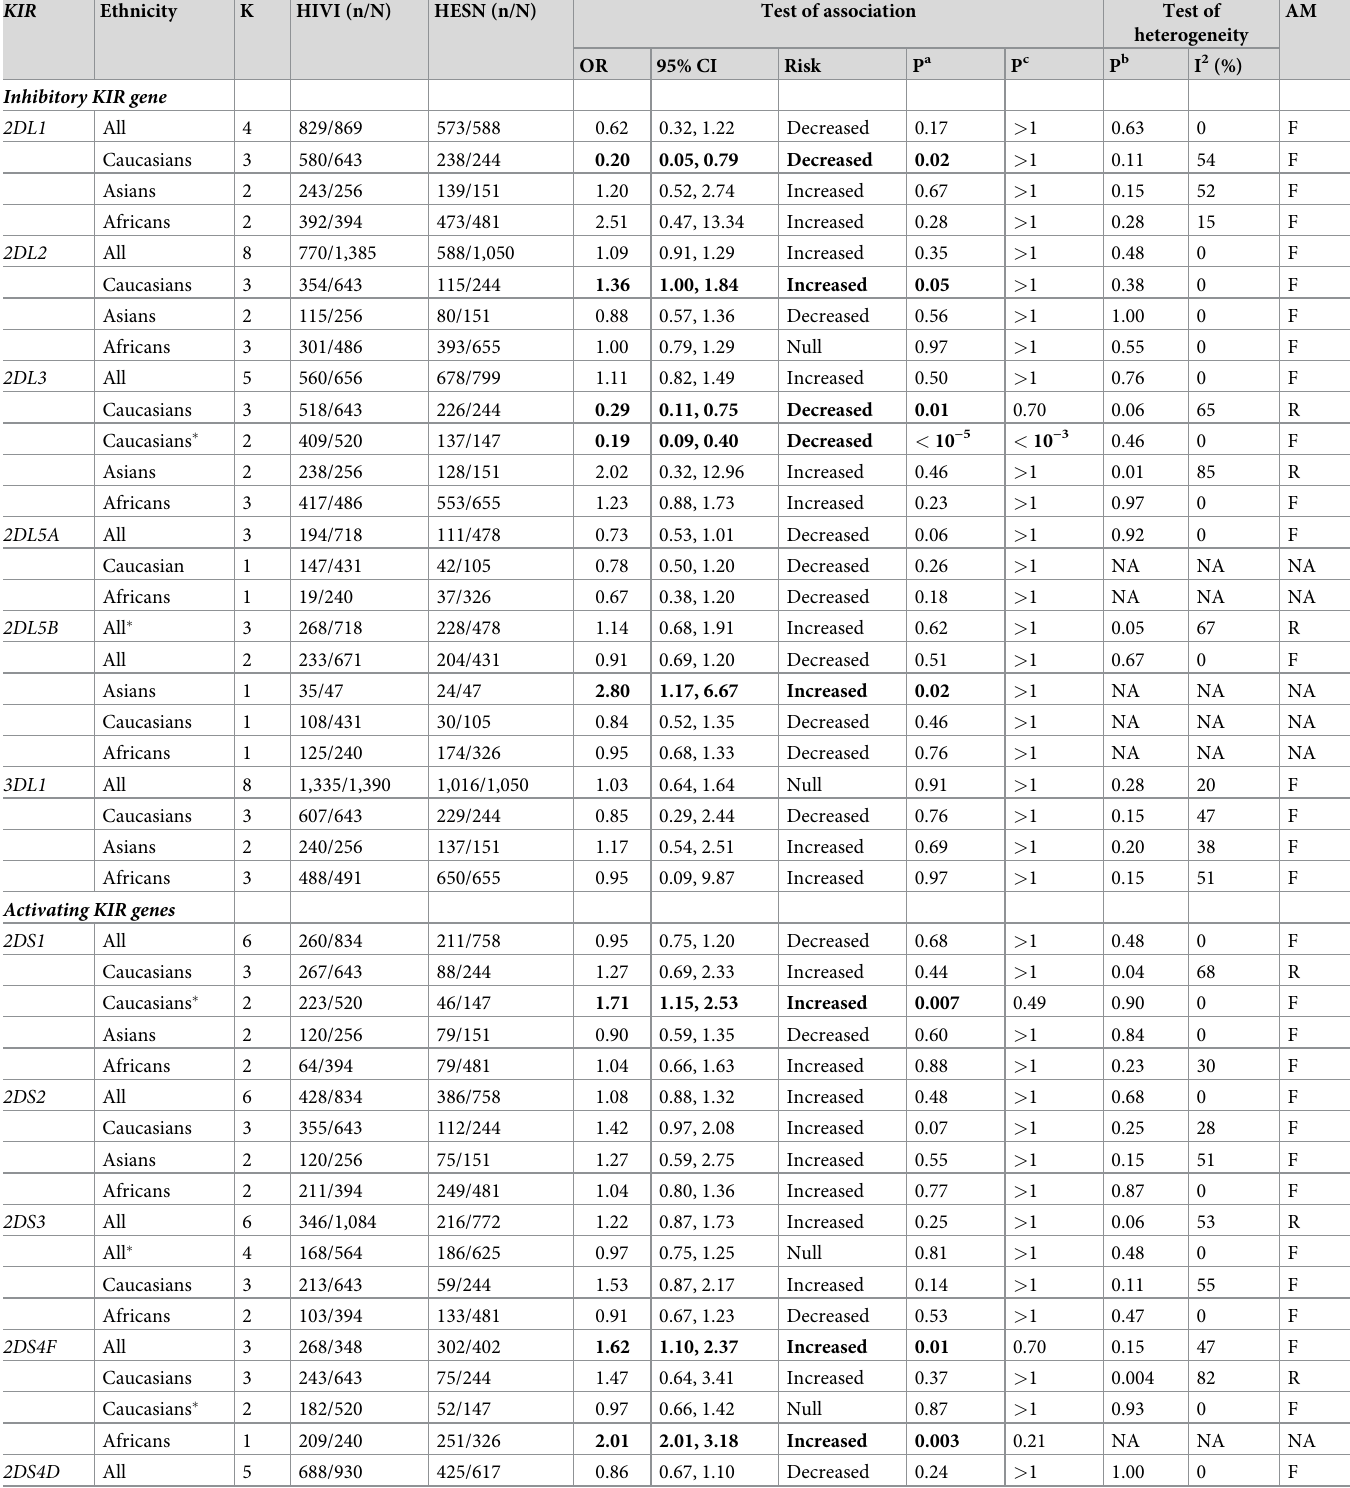
Table 2. Associations of KIR gene content polymorphisms with HIV acquisition.